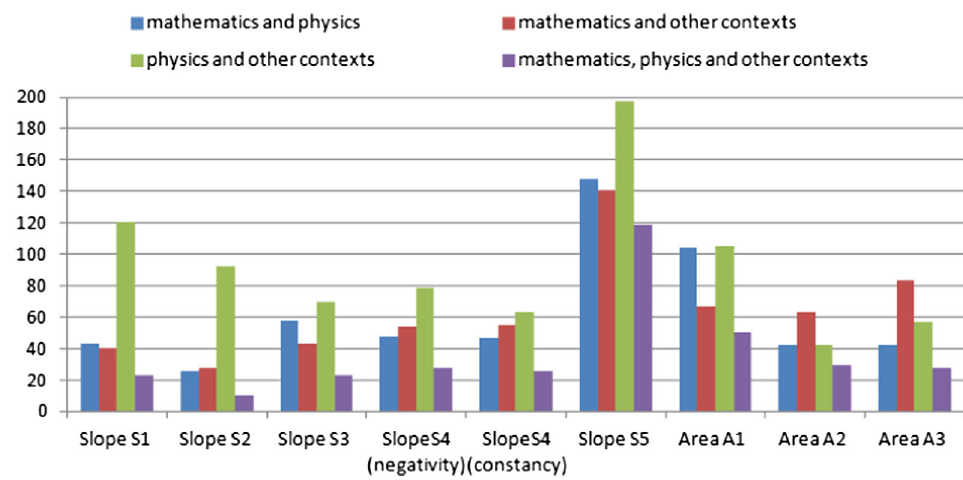
FIG. 7. Number of students on each set of questions who used same strategies in different combinations of